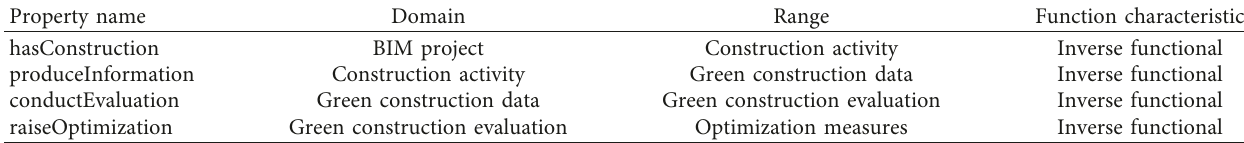
Table 6: Definitions of object properties.